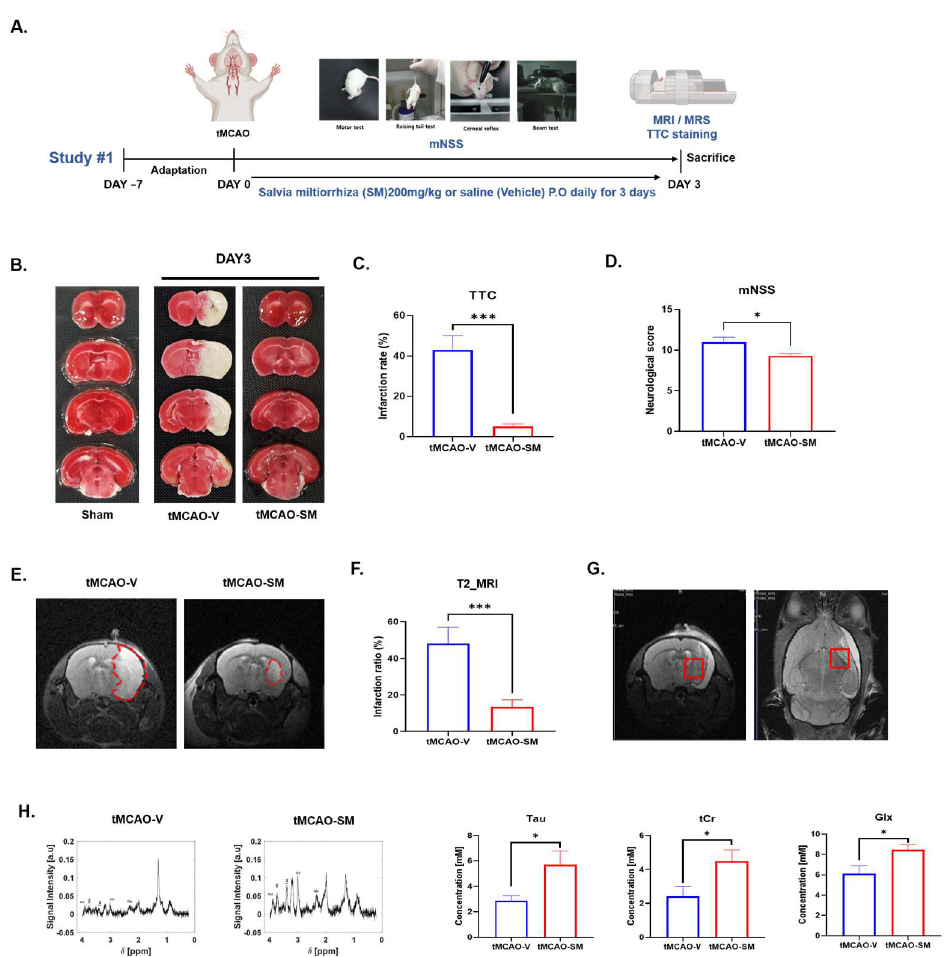
Figure 1. SM administration reduced cerebral I/R injury and recovered metabolites in tMCAO mouse brain. ( A ) Experimental scheme. ( B ) TTC staining and ( C ) quantification of infarction ratio between tMCAO-V and tMCAO-SM group. ( D ) mNSS score. (tMCAO-V, n = 7; tMCAO-SM, n = 7) ( E ) Representative image of penumbra area (Red dotted) in tMCAO-V and tMCAO-SM groups and ( F ) quantification of penumbra area in MRI T2 imaging. (tMCAO-V, n = 8; tMCAO-SM, n = 12) ( G ) Signal intensity of magnetic resonance spectroscopy between tMCAO-V and tMCAO-SM. ( H ) Metabolites analysis between tMCAO-V and tMCAO-SM group. Values are expressed as the mean ± SEM. (Tau, tMCAO-V, n = 7; tMCAO-SM, n = 7; Cr, tMCAO-V, n = 8; tMCAO-SM, n = 7; Glx, tMCAO-V, n = 8; tMCAO-SM, n = 6) Statistical analysis between the two groups was performed using unpaired t test. * p < 0.05 and *** p <